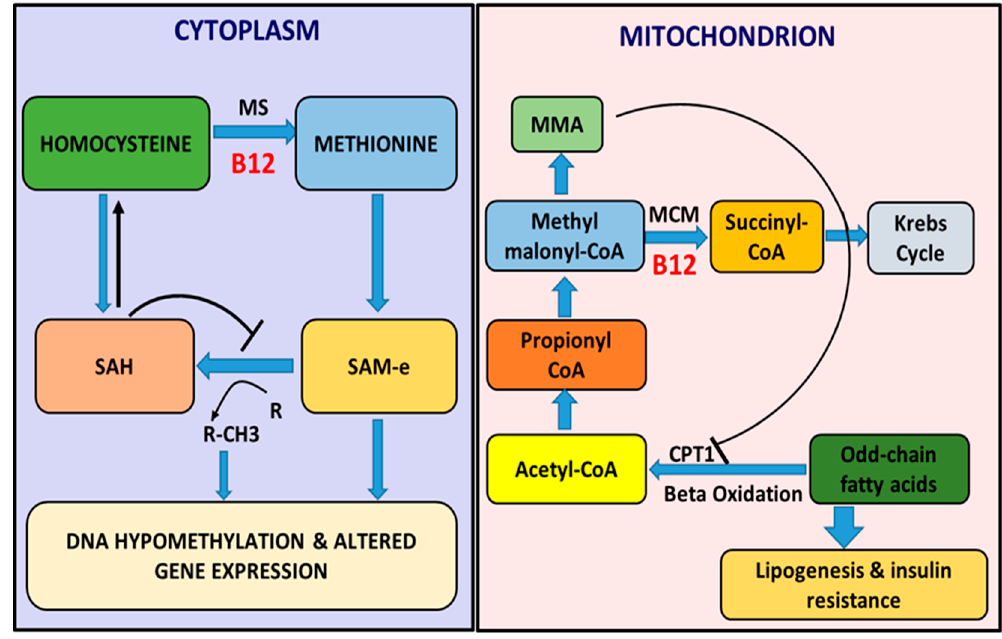
Figure 2. Cellular role of B12 in lipogenesis. There is a reduction in the production of methionine as well as the methyl donor s-adenosyl methionine (SAM) within the cell’s cytosol, resulting from B12 deficiency, leading to hyperhomocysteinemia as well as reversible increase in s-adenosyl homocysteine (SAH) which is known to be an inhibitor of DNA methyl transferases (DNMTs). The inhibition of DNMTs together with low levels of SAM results in hypomethylation of DNA and altered gene expressions. Beta oxidation of fatty acid is inhibited by generation of methyl malonic acid (MMA) from methyl malonyl-CoA within the mitochondria due to insufficiency of B12, a cofactor for methyl malonyl-CoA mutase (MCM) enzyme required for the biosynthesis of succinyl-CoA from methyl malonyl-CoA in the propionate metabolism pathway.